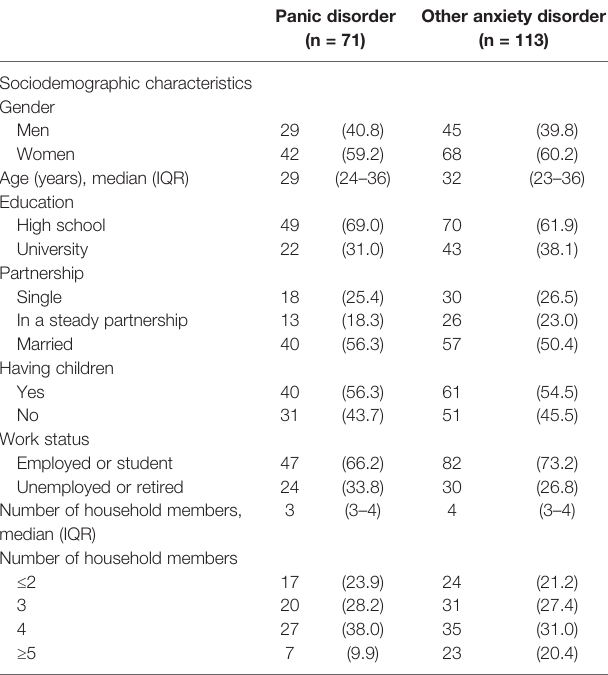
TABLE 1 | Participants ' sociodemographic characteristics.